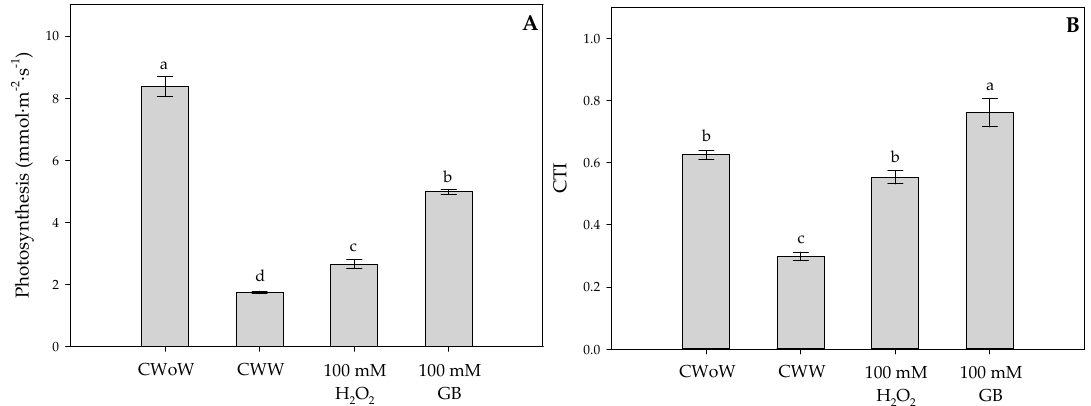
Figure 3. ( A ) Photosynthesis and ( B ) canopy temperature index (CTI) of Cape gooseberry ( Physalis peruviana L.) plants ecotype Colombia subjected to two waterlogging periods with treatments of control without waterlogging (CWoW), control with waterlogging (CWW), 100 mM of hydrogen peroxide (H 2 O 2 ) and 100 mM of glycine betaine (GB). Evaluated at 36 Days After Waterlogging (DAW). Each point represents the mean of the four values. Data represent the average of ten plants ± standard error per treatment ( n = 5). Bars followed by different letters indicate statistically significant differences according to the Tukey test ( p ≤ 0.05).